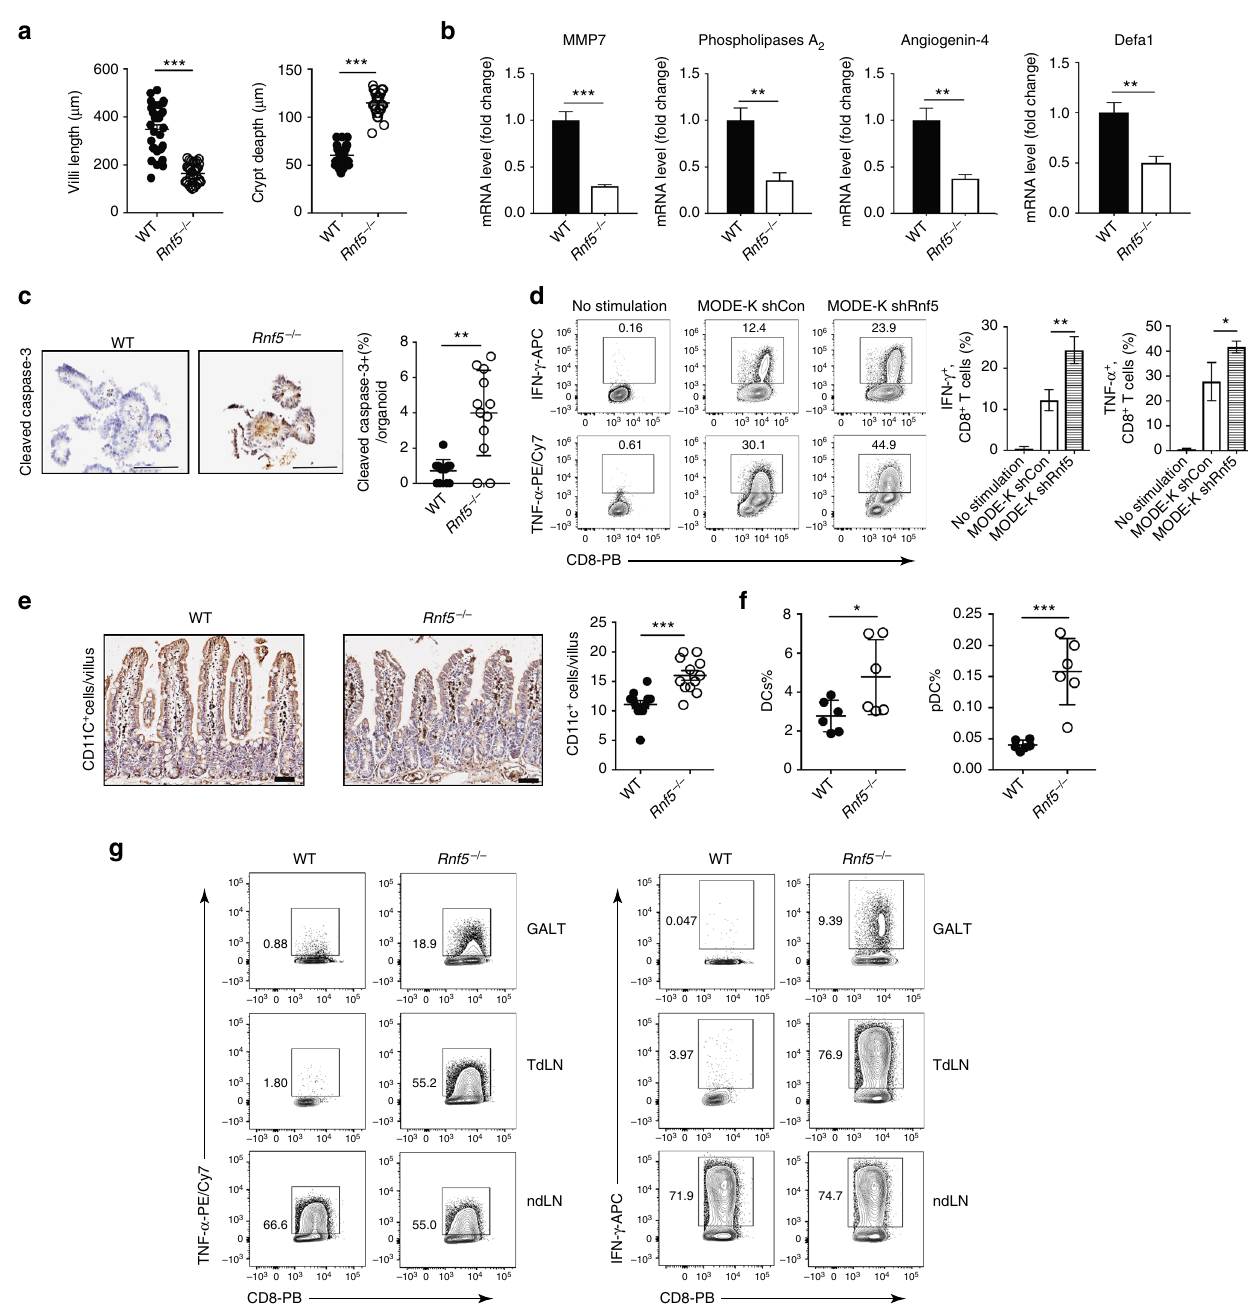
Fig. 5 IEC of Rnf5 − / − mice activate immune response and change anti-microbial peptide (AMP) expression. a Villi length and crypt depth calculated from H&E-stained sections of intestines from WT or Rnf5 − / − mice (WT, n = 30; Rnf5 − / − , n = 32). b qRT-PCR analysis of AMPs mRNA levels in IECs from small intestine of naive WT or Rnf5 − / − mice ( n = 6). c Representative images (left) and quanti fi cation (right) of cleaved caspase-3 immunostained small intestine organoids from tumor-bearing WT or Rnf5 − / − mice ( n = 3). Scale bar = 100 μ m. Graph shows percentage of cleaved caspase-3 + cells per immunostained organoid ( n = 12 fi elds). d Intracellular IFN- γ and TNF- α staining of p14 CD8 + T cells incubated for 72 h with 2 μ g/ml GP33 peptide recognized by the TCR of P14 and bone marrow-derived dendritic cells (BMDCs) that were incubated with medium alone (no stimulation) or with conditioned medium (CM) from shControl or shRNF5 MODE-K cells. e Representative images (left) and quanti fi cation (right) of CD11c + cell immunostaining in the small intestine of WT or Rnf5 − / − mice on day 24 after injection of YUMM1.5 cells. Scale bar = 50 μ m ( n = 4). f Frequencies of total DCs and pDCs in Peyer ’ s patches from WT and Rnf5 − / − mice on day 10 after YUMM1.5 cell injection ( n = 6). g 10 days after tumor injection, DCs from GALT, dLN, and ndLN were isolated, pooled per group ( n = 10 mice/group), and were incubated with OT-1 CD8 + T cells stimulated with 2 μ g/ml OVA peptide (SINFEKL). Intracellular IFN- γ and TNF- α of OT-1 CD8 + T cells were detected. Data are representative of three independent experiments ( b , d ) and two independent experiments ( a , c , e , f , g ) ≥ 3 mice per group. Graphs show the mean ± s.e.m. * P < 0.05, ** P < 0.005, *** P < 0.001, **** P < 0.0001 by two- tailed t test or Mann – Whitney U test ( a , b , c , e , f ) or one-way ANOVA with Tukey ’ s ( d ) correction for multiple